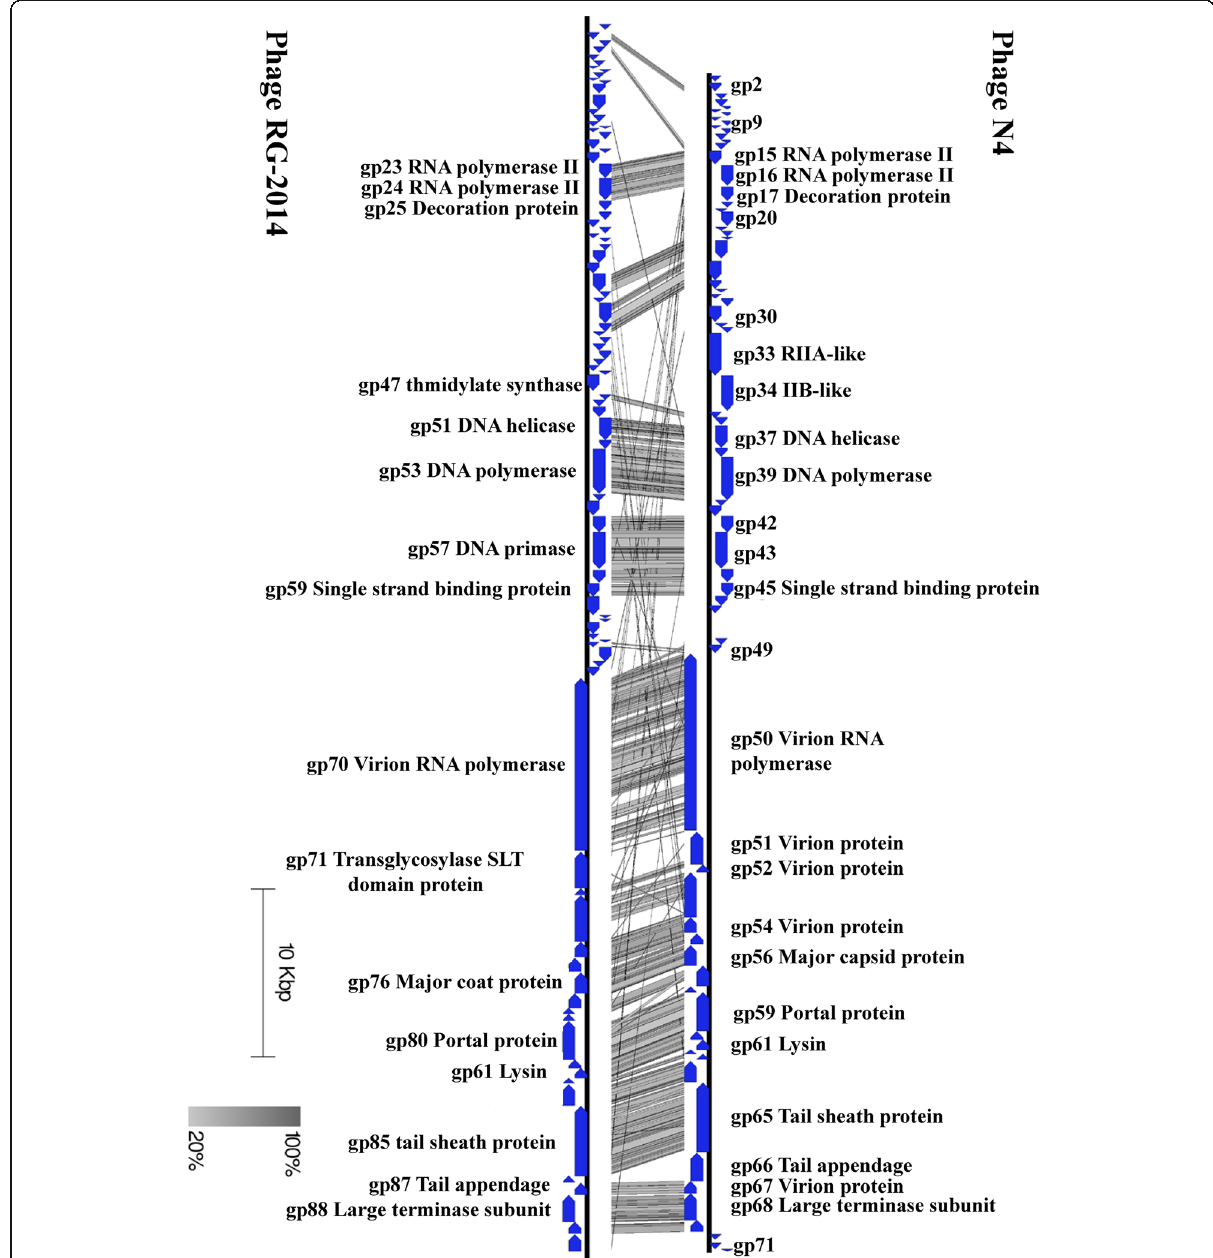
Fig. 3 Whole genome comparison of Delftia phage RG-2014 (KM872991.2) phage to E. coli phage N4 (NC_008720). The Figure was generated with Easyfig [38]. Genomes were aligned using Easyfig [38]. The functions of genes in phage N4 are shown above and predicted functions of RG-2014 genes are indicated below the